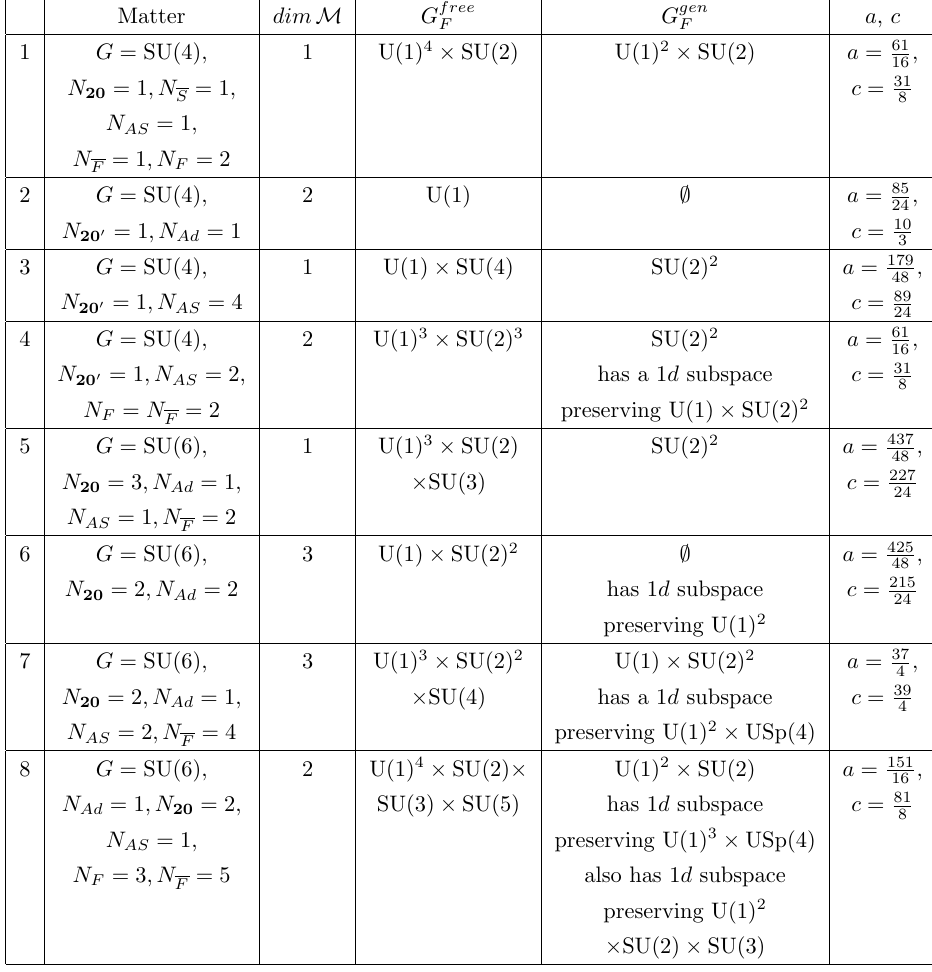
Table 9 . Cases involving an SU( N ) gauge group with ‘exotic’